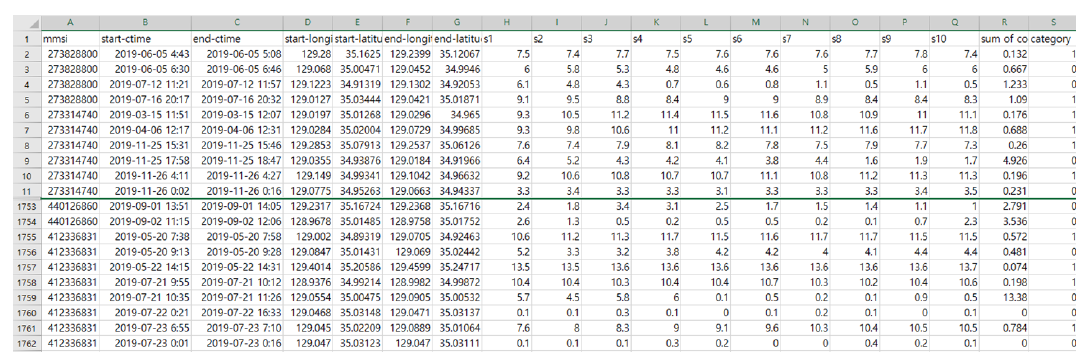
Figure 9. AIS Data Extraction Range. Table 4. Preprocessing of AIS Data.